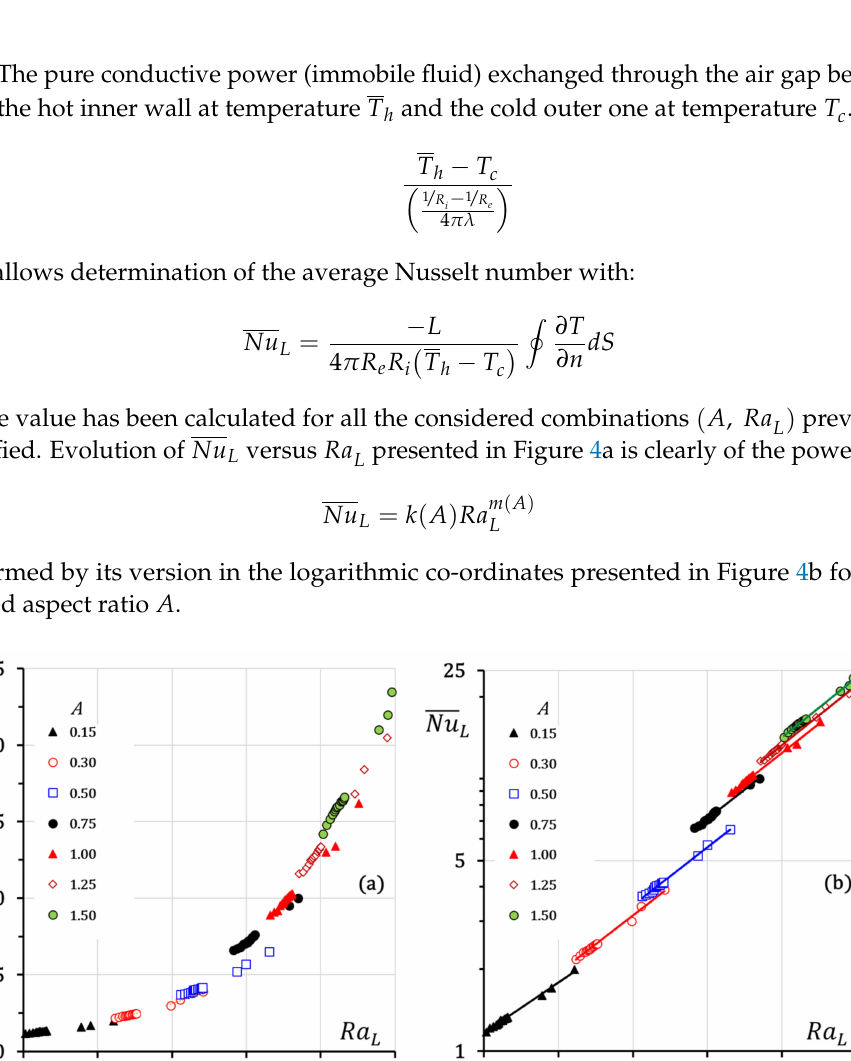
( a ) semi-logarithmic co-ordinates; ( b ) logarithmic L